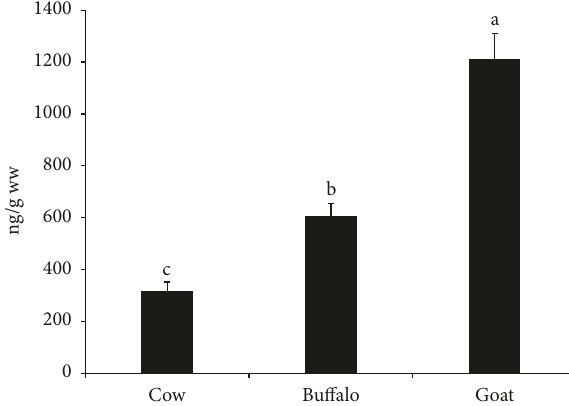
Figure 2: Total organochlorine pesticide residues (OCPs) in the examined milk samples. Data represent mean ± SE (ng/g ww) for total OCPs in the examined milk samples from different animal species (n=20 each). Columns that carry different superscript letter are significantly different at p <